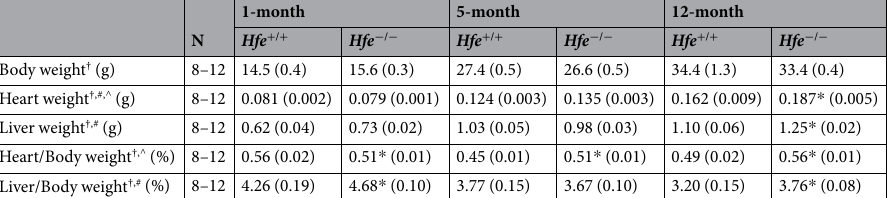
Table 1. Physiological characteristics of Hfe-deficient mice at 1, 5 and 12 months of age. Data are presented as the means (SEM). Two-way ANOVA was employed to assess the main effects (age and Hfe gene) as well as interaction effects (age x Hfe gene), followed by the Tukey’s post-hoc analysis for pairwise comparisons (Systat; version 13). † p < 0.05, age effect. # p < 0.05, Hfe effect. ^ p < 0.05, age x Hfe effect. * p < 0.05, Hfe − / − vs. age- matched Hfe + / +